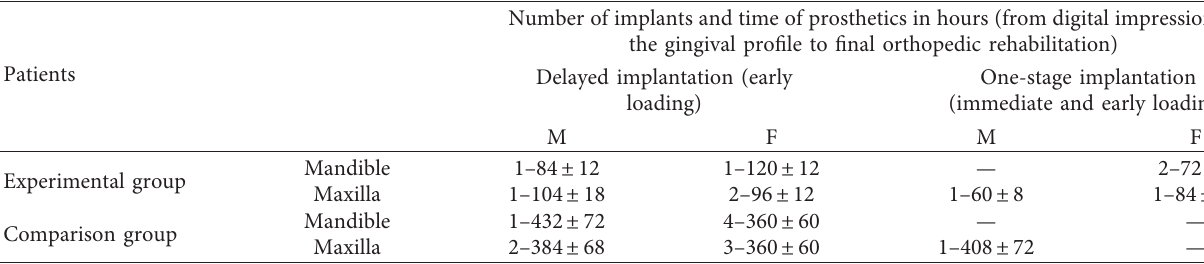
Table 4: Timing of the final orthopedic